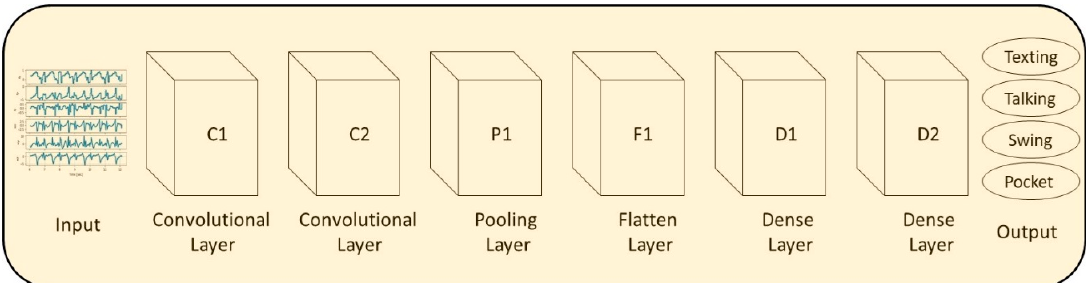
Figure 5. The CNN network architecture used for the evaluation of SLR.